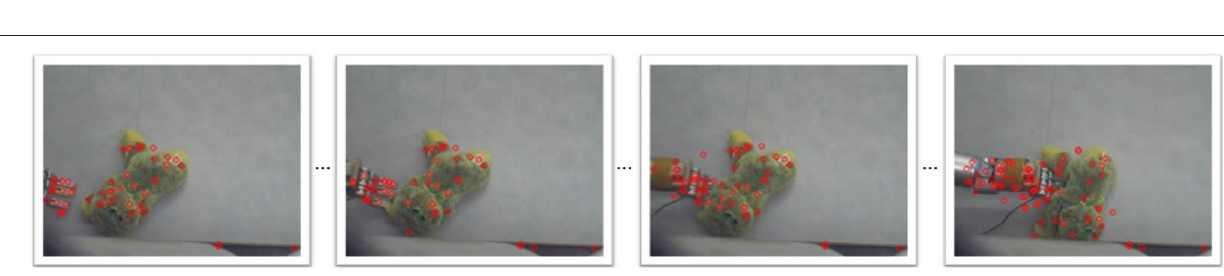
FIGURE 7 | Visual (SURF) features detected when the tap behavior was performed on an object from the large stuffed animals category. The feature descriptors of the detected interest points over the entire interaction were represented using